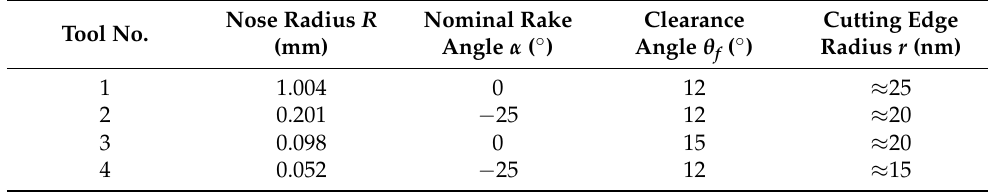
Figure 2. Schematic diagram of cutting experiments ( a ) by tools 1 and 2 on the front crystal surface, and ( b ) by tools 3 and 4 on the back crystal surface; ( c ) Processing procedure for each shoulder region ( f : feed; a p : cutting depth; and v : cutting speed). Table 1. Geometry parameters of cutting tool.